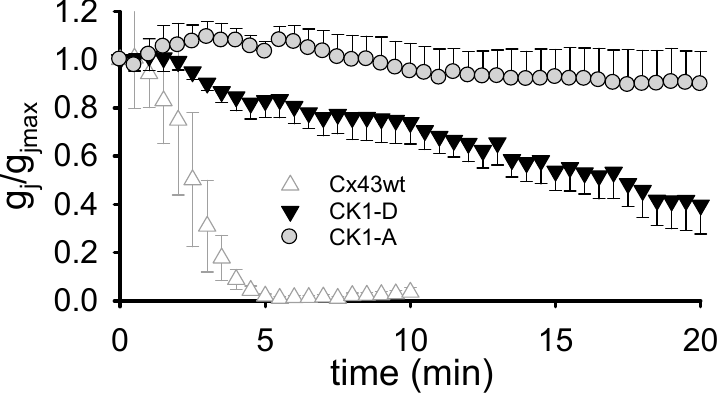
Figure 4. Cx43-CK1-D and Cx43-CK1-A mutants form gap junctions resistant to closure by low pH. Superfusion (starting at time 0) with a bicarbonate solution buffered at pH = 6.0–6.2 caused slow g j decrease in Cx43-CK1-D (black triangles; n = 6), and no g j decrease in Cx43-CK1-A (gray circles; n = 4) during an observation period of ≥ 20 min. The response of Cx43WT junctions to similar treatment (white triangles; n = 5) is reproduced from [14] for comparison.